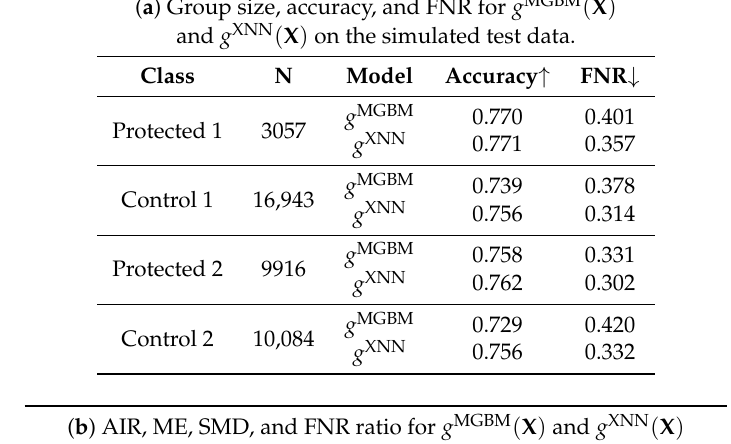
Table A1. Discrimination measures for the simulated test data. Arrows indicate the direction of improvement for each